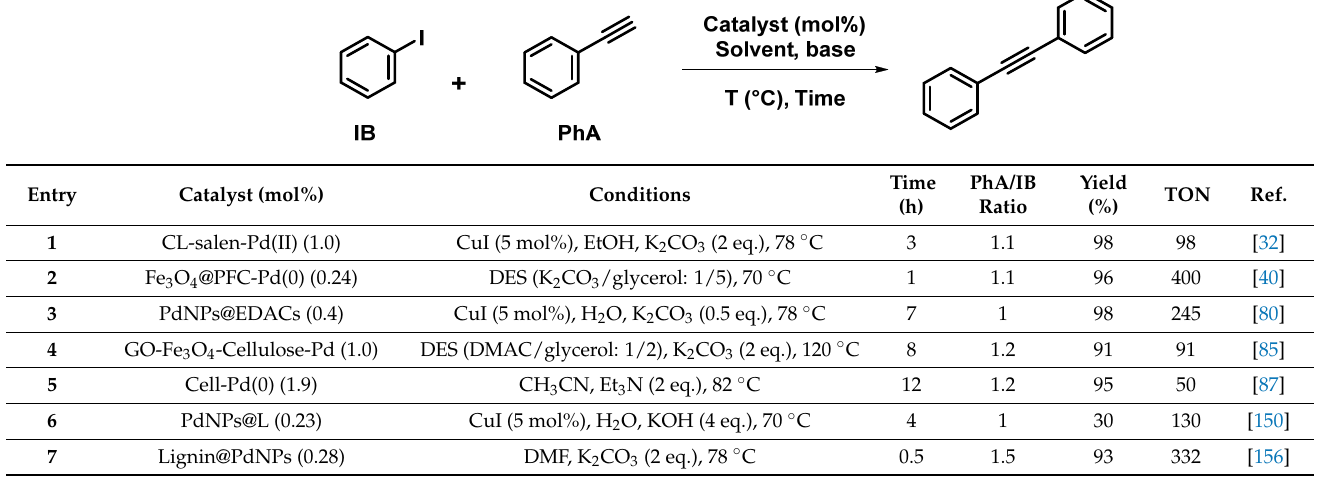
Table 3. Sonogashira cross-coupling reaction between iodobenzene (IB) and phenyl acetylene (PhA). Comparison of the reaction conditions and results from different articles.